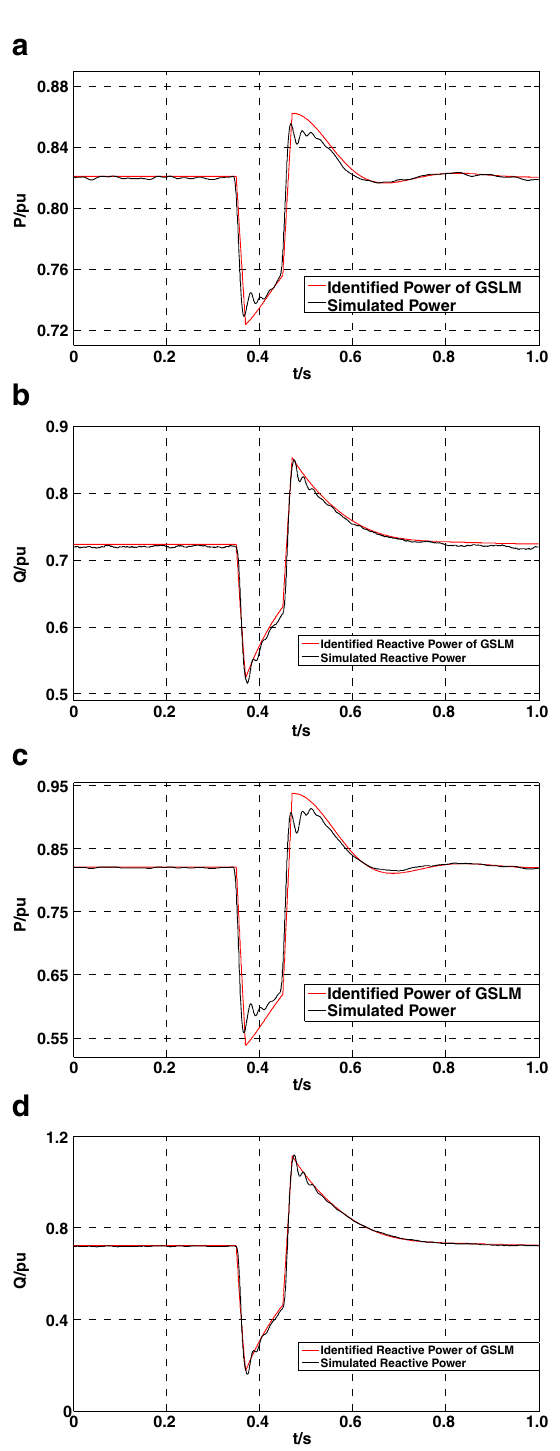
Fig. 15 Interpolation and extrapolation capability verification